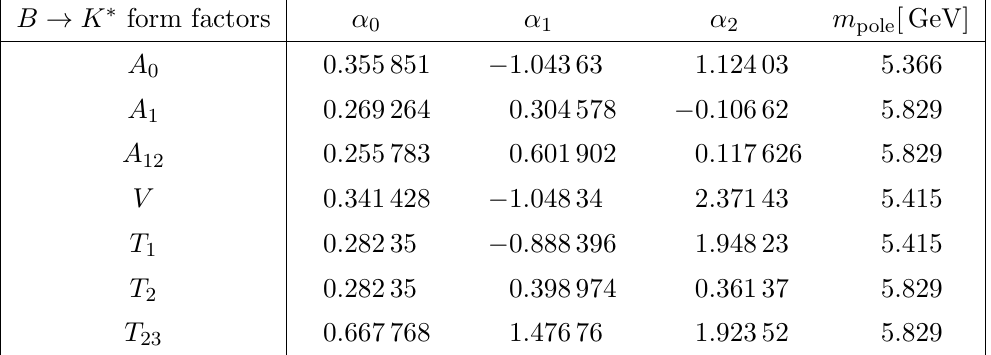
Table 3 . Central values of the (cid:11) 0 ; 1 ; 2 parameters and resonance masses m pole , entering in the evaluation of the B ! K (cid:3) form factors A 0 ; 1 ; 12 , V , and T 1 ; 2 ; 23 , as provided in [21].